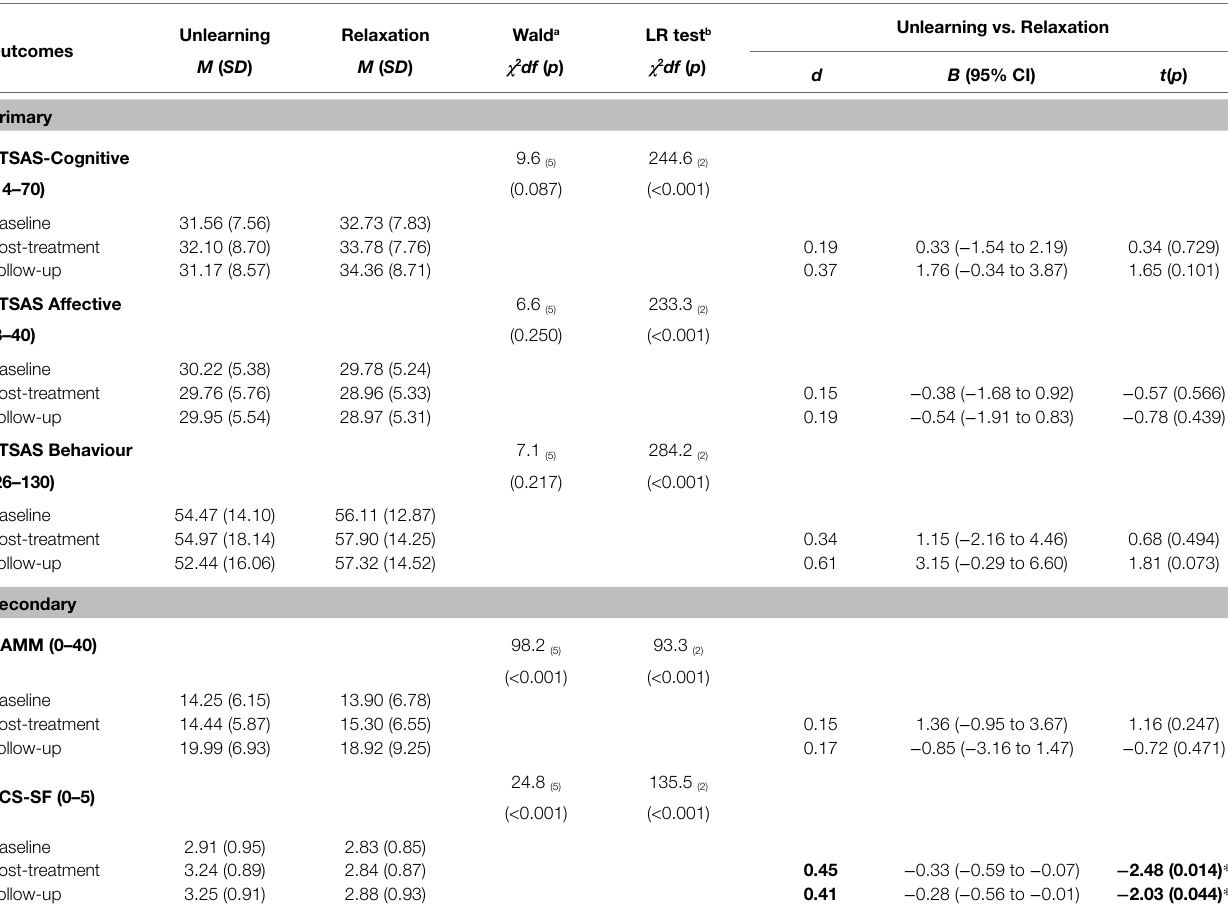
TABLE 3 | Between-group analyses for primary and secondary outcomes (ITT